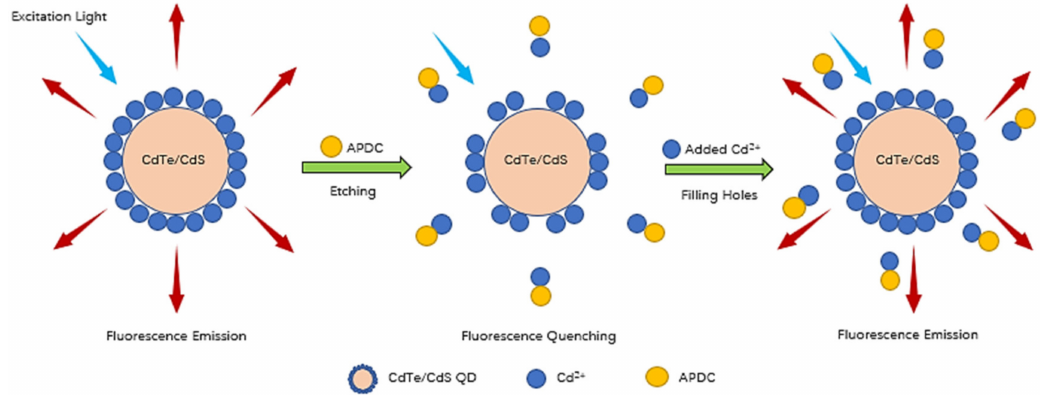
Figure 1. The reaction mechanism of the turn-on mode CdTe / CdS quantum dots (QD)